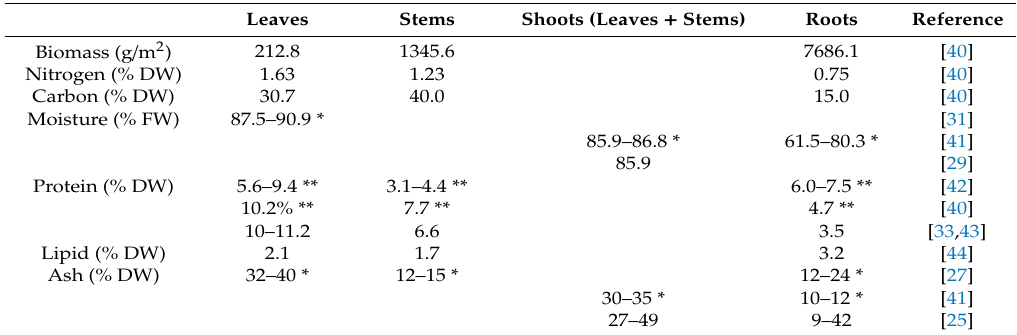
Table 1. Dry biomass and approximate composition values of A. portulacoides biomass (FW = fresh weight, DW = dry